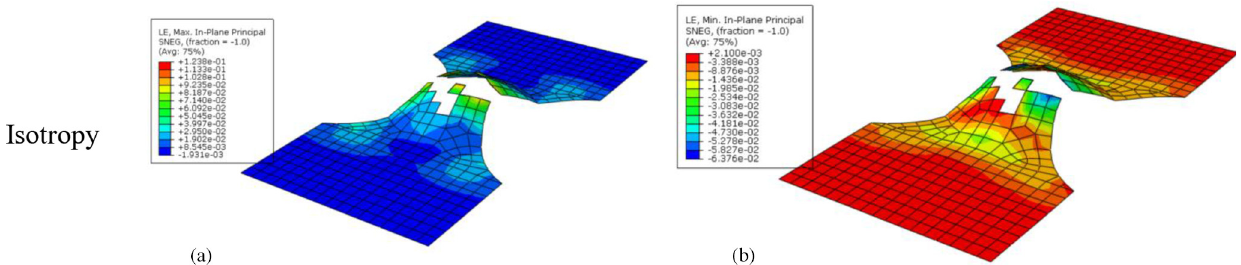
Fig. 13. (a) Maximum in-plane principle strain under uniaxial stretching. (b) Minimum in-plane principle strain under uniaxial stretching.